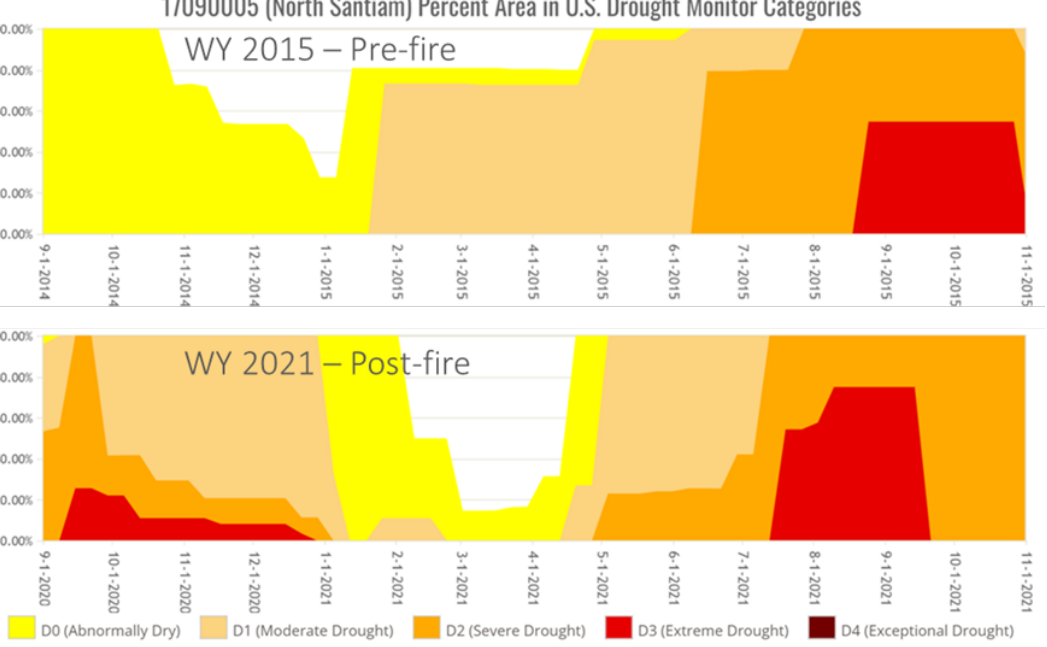
Figure 6. Comparison of pre- and post-fire year percentage area of North Santiam watershed (HUC 17090005) in U.S. drought monitoring categories. The figure was created using the web-based tool available at U.S. Drought Monitor